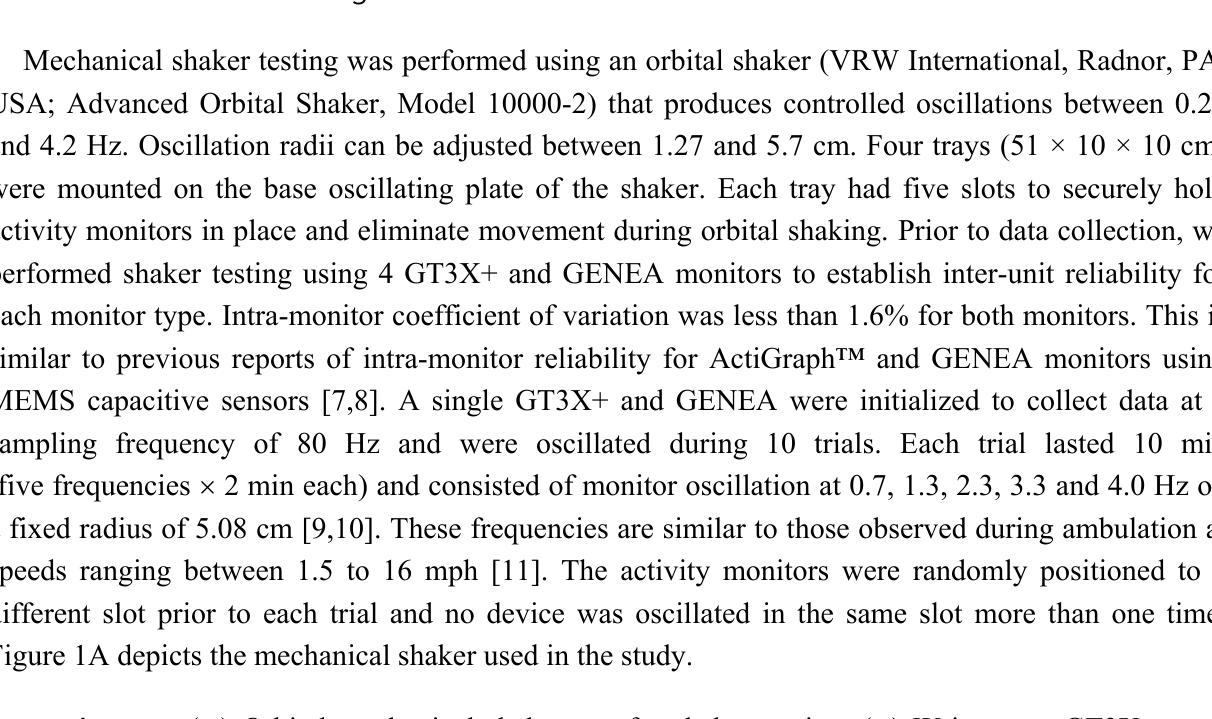
Figure 1. ( A ) Orbital mechanical shaker use for shaker testing, ( B ) Wrist worn GT3X+ and GENEA